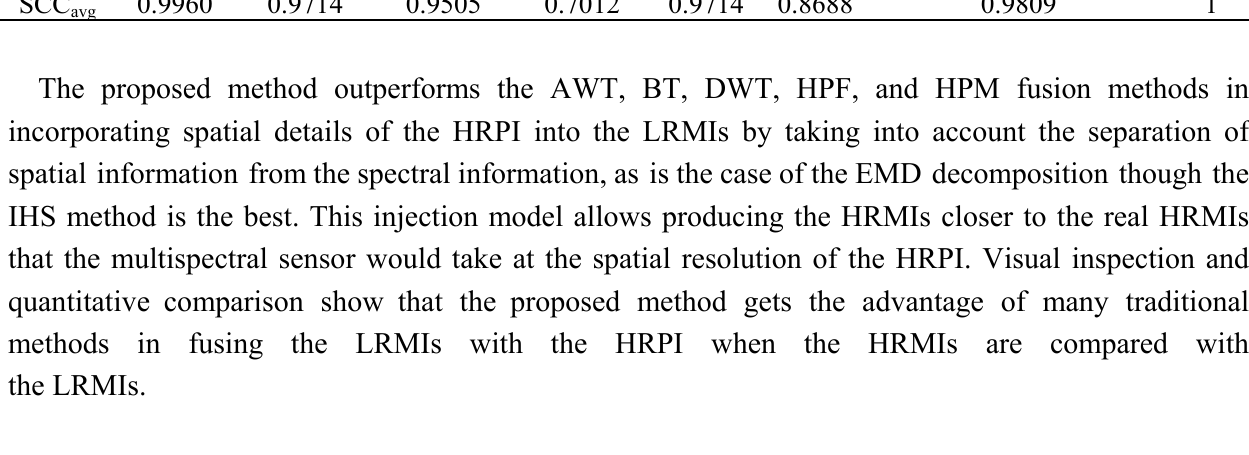
Table 3 . the SCC comparison between the spatial detail of the average HRMI and the HRPI avg IHS AWT BT DWT HPF HPM SCC 0.9960 0.9714 0.9505 avg